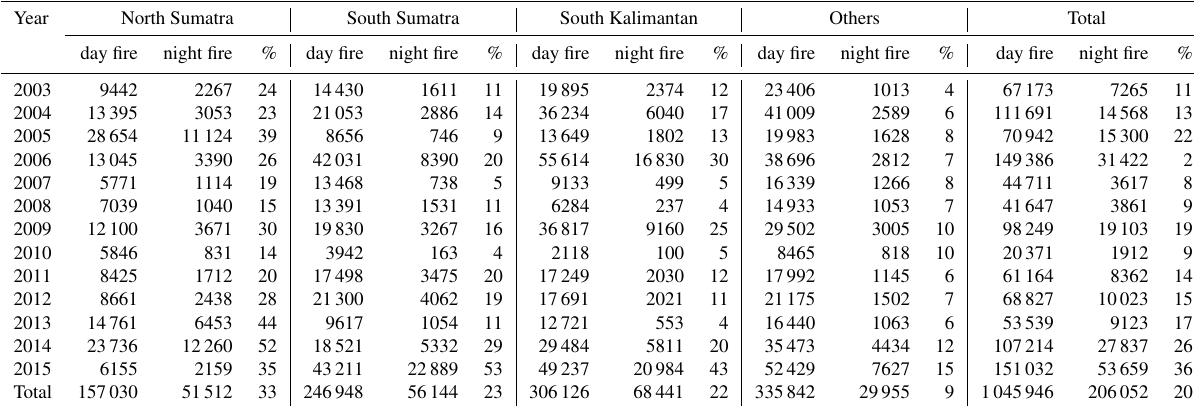
Table 2. MODIS Terra (22:30 LT) and MODIS Aqua (14:30 LT) active fire